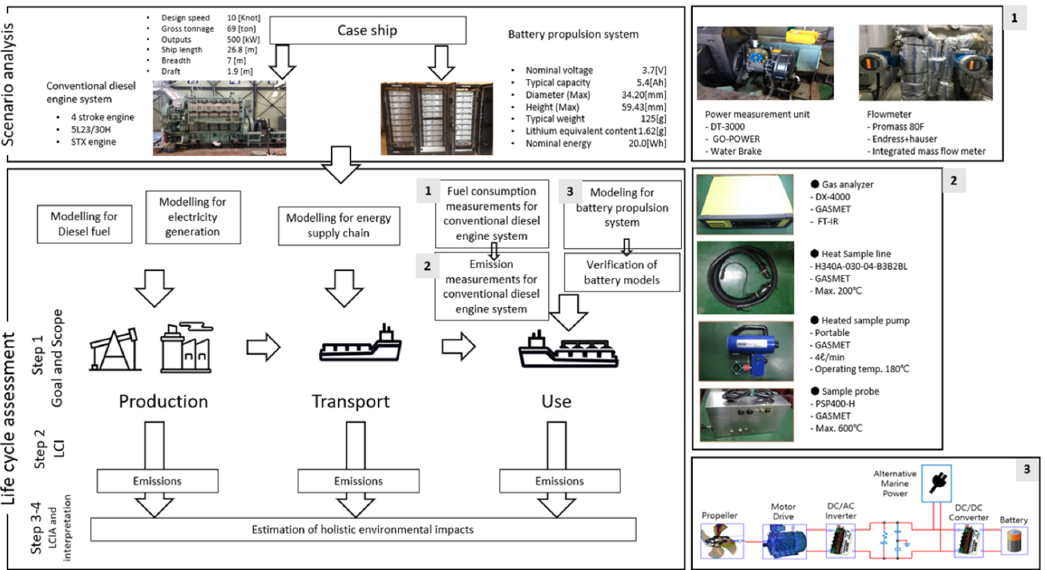
Figure 1. Outline for the life cycle environmental assessment for battery ships and diesel ships: (1) fuel consumption measurements for diesel engine; (2) Emission measuring devices; (3) battery propulsion system modeling.